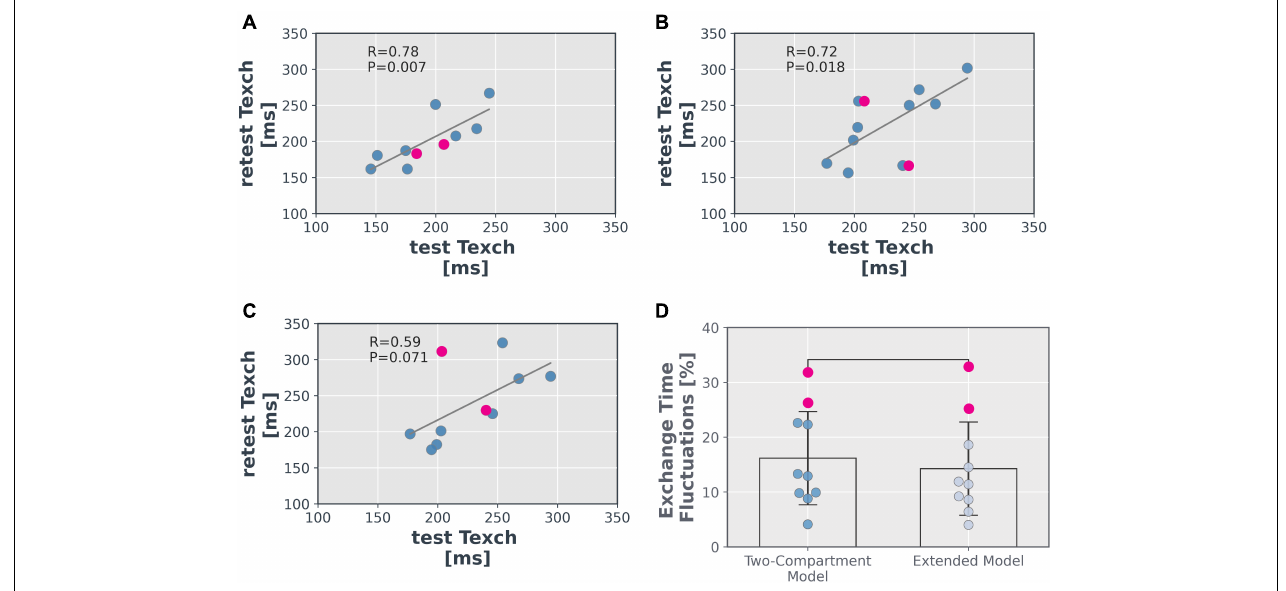
FIGURE 10 | Scatter plots of mean grey matter Texch from (A) intra-session, (B) inter-session and (C) inter-visit using the extended model. (D) Fluctuations measured within the Texch values estimated by the models in terms of the normalised difference between the two visits ( P = 0.321). Inter-session data from two subjects showed a notably low ASL signal (difference of a factor of 2) in the decoded images possibly due to improper shimming or inefficient labelling and is shown in pink data